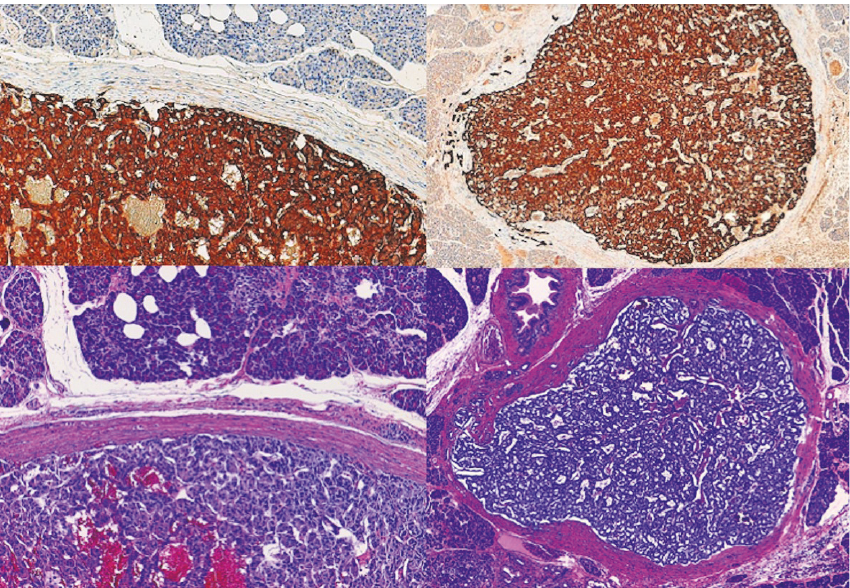
Figure 4: Immunohistochemistry with positive cells for